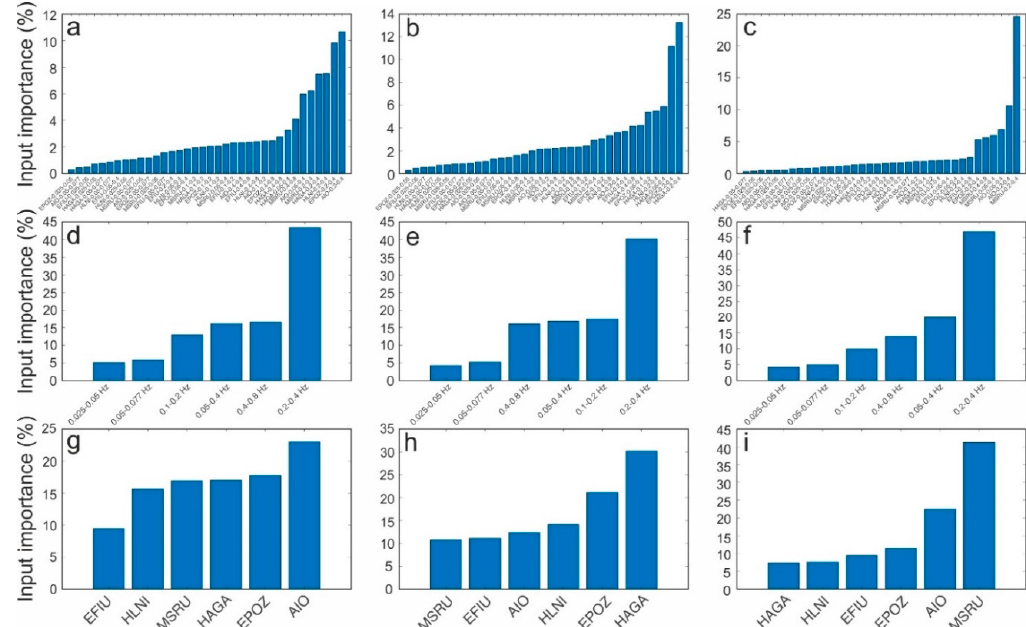
Figure 9. ( a – c ) Index of importance of all the inputs taken into account for the three grid cells labelled “a,” “b,” and “c” in Figure 6, respectively. ( d – f ) Aggregation through summation of the input